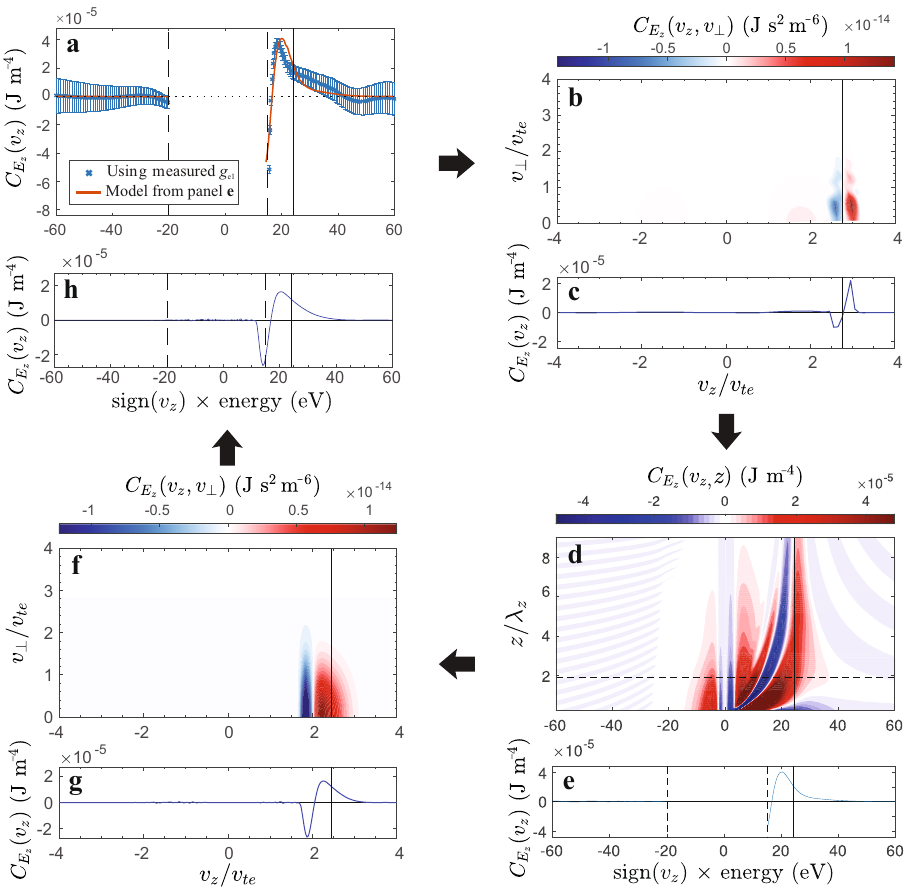
ð v Þ and C ð v ; v Þ . Results from a LAPD experiment, b , c AstroGK simulation, d , e an analytical Laplace-Fourier Fig. 3 Field-particle correlations C E z E z z ? z ð v Þ , and g , f , h Liouville mapping. h is a re-plotting of ( g ) with axes for direct comparison with ( a ). Gyrotropic Transform solution of the z / λ evolution of C E z z ð v ; v Þ in ( b , f ) are reduced to the parallel correlations C ð v Þ in ( c , g ) by integration over v ⊥ . The parallel phase velocity v correlations C E ? z E z z z black vertical line on all plots. WWAD measurements are unavailable in the region bounded by vertical dashed lines. The dashed horizontal line in ( d ) identi fi es the slice re-plotted in ( e , a ) and corresponds to the z / λ z location of WWAD measurements in the experiment. The AstroGK C E a bipolar signature centered on v ph , is comparable to the largest values of z / λ z in ( d ). The analytical ( e ) and Liouville mapping ( g ) C ð v Þ . Error bars in ( a ) represent the standard deviation. The of the experiment and produce a bipolar signature below v ph similar to ( a ) the experimental C E z z black arrows represent the path of analytical and numerical analysis leading to closure in the interpretation of our experimental